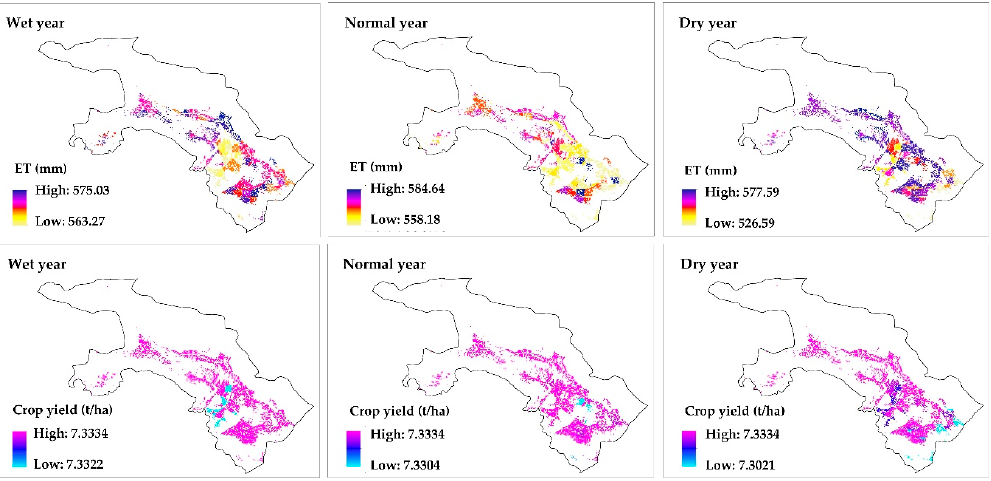
Figure 11. Distribution of minimal evapotranspiration (ET) and maximal crop yield under different climate years after irrigation optimization conditions.